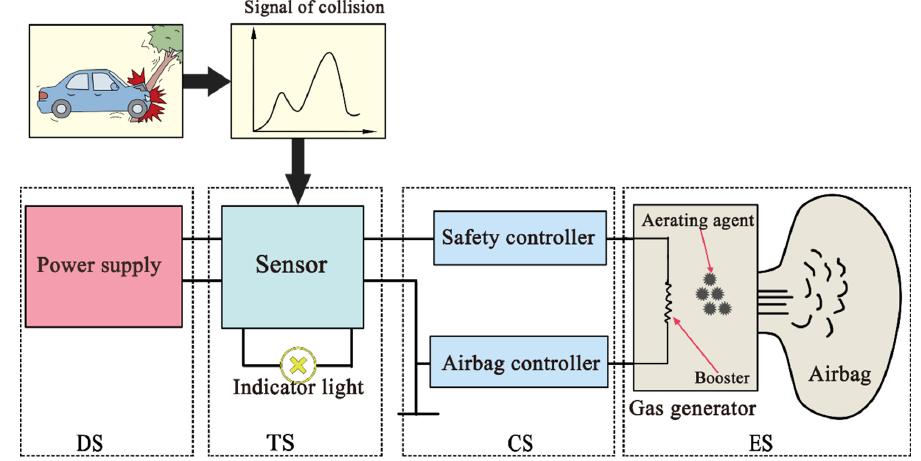
Figure 7. The airbag